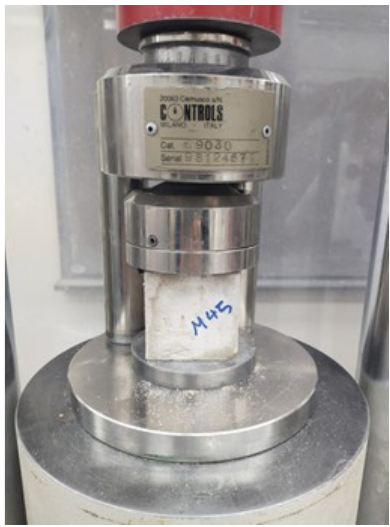
Figure 4. Compression testing machine.